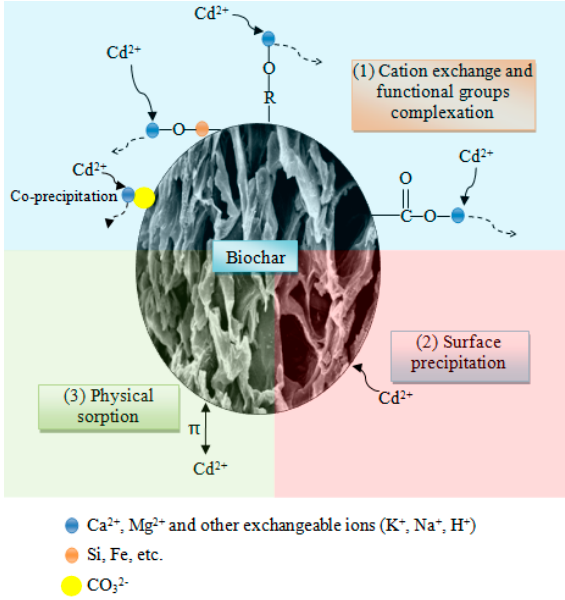
Figure 15. The mechanisms of Cd removal by biochars.